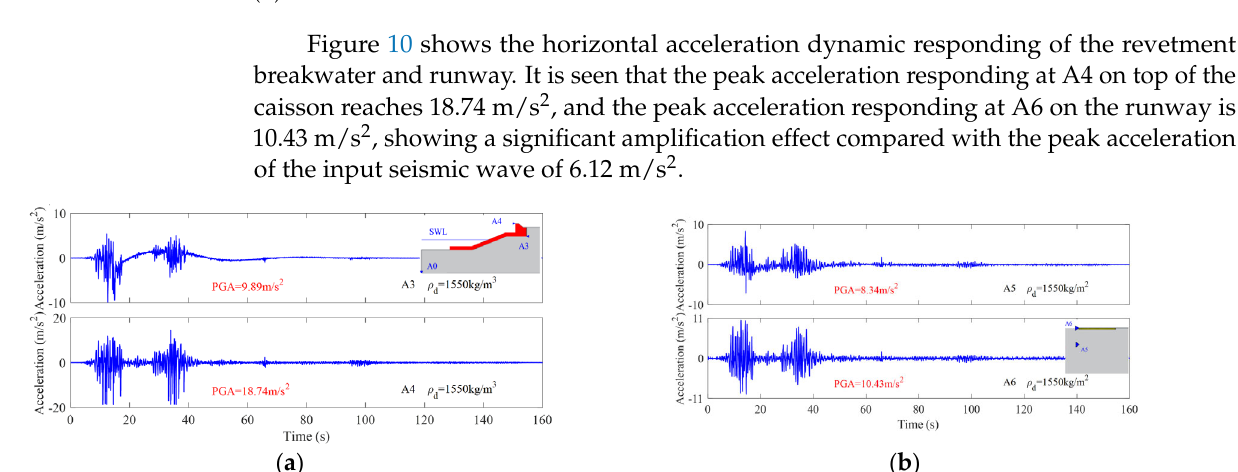
Figure 9. Dynamic responding of acceleration at typical positions A0, A1, and A2. ( a ) Horizontal. ( b ) Vertical.